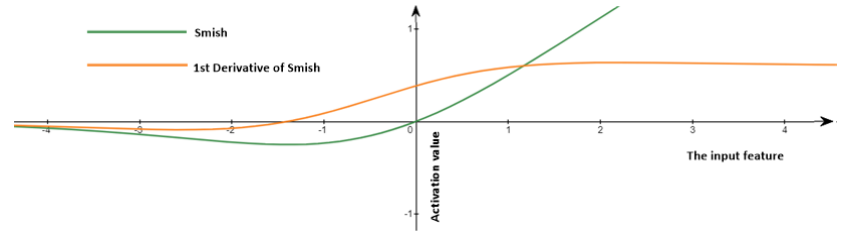
Figure 2. Curves of the Smish activation function and its derivative.